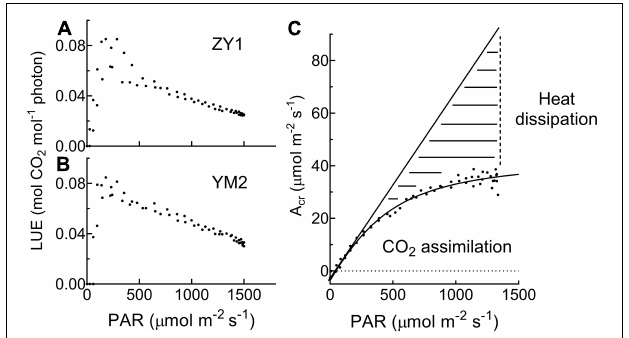
FIGURE 3 | The relationship between light use efficiency (LUE) and photosynthetic active radiation (PAR) is based on data at the heading stage for ZY1 (A) and YM2 (B) . The response of whole plant CO 2 flux (A cr ) under different PAR (C) shows that a large portion of the incident light is used for heat dissipation, rather than photochemistry. The dashed area shows the light used for heat